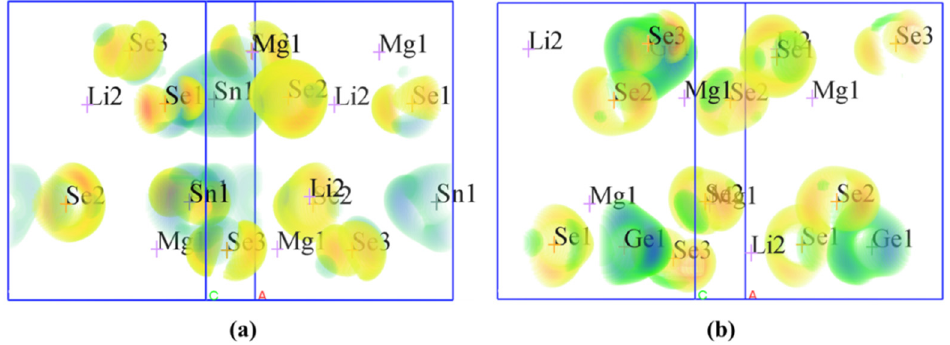
Figure 3. Calculated band structures of ( a ) Li 2 MgSnSe 4 and ( b ) Li 2 MgGeSe 4 ; total and partial density of states and the band-resolved NLO susceptibility χ (2) of ( c ) Li 2 MgSnSe 4 and ( d ) Li 2 MgGeSe 4 .